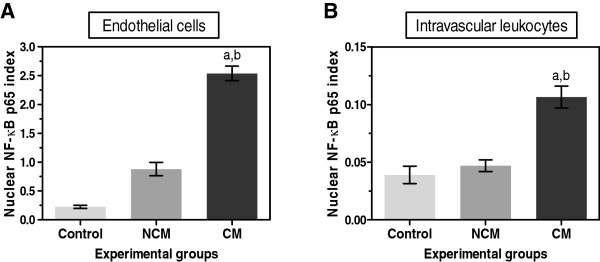
Quantitative analysis of nuclear NF-κB p65 index in vascular ECs and in intravascular lymphocytes in the brains of control, NCM and CM groups. The graphs show NF-κB p65 expression in vascular ECs (A) and intravascular leukocytes (B) in three experimental groups. aSignificance of p < 0.001 compared with control brain (Mann–Whitney U test). bSignificance of p = 0.034 compared with NCM (Mann–Whitney U test). Data are presented as mean ± SEM.